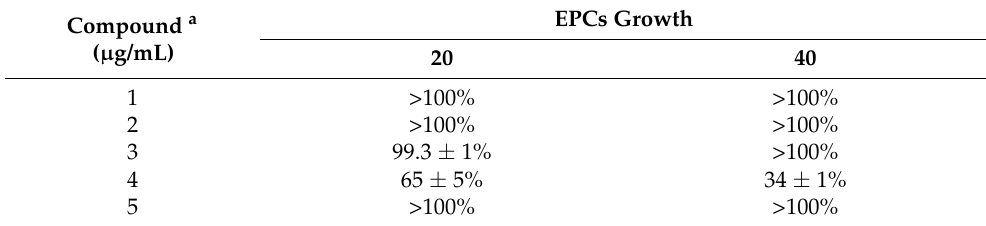
Table 3. Anti-angiogenic effects of isolated compounds in human EPCs.